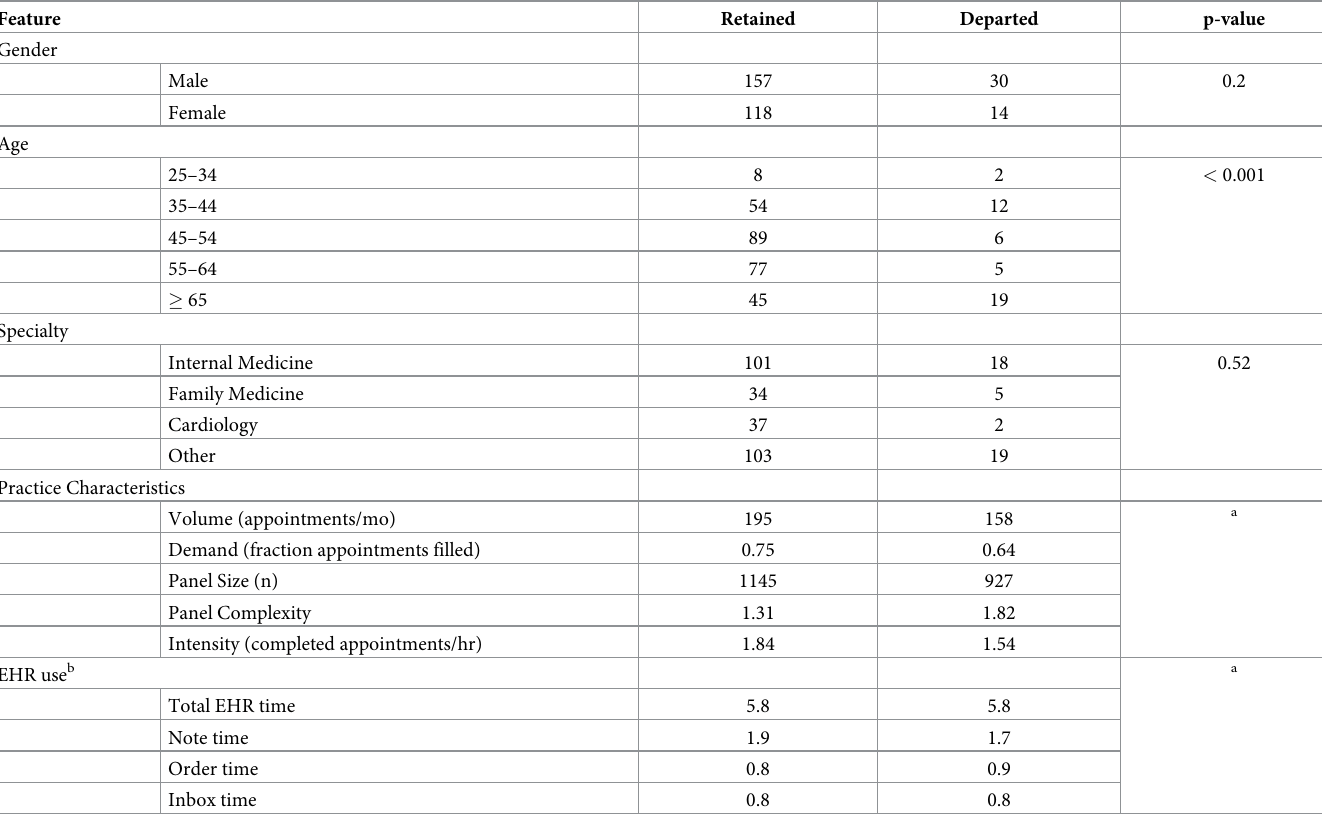
Table 1. Physician feature values stratified by departure